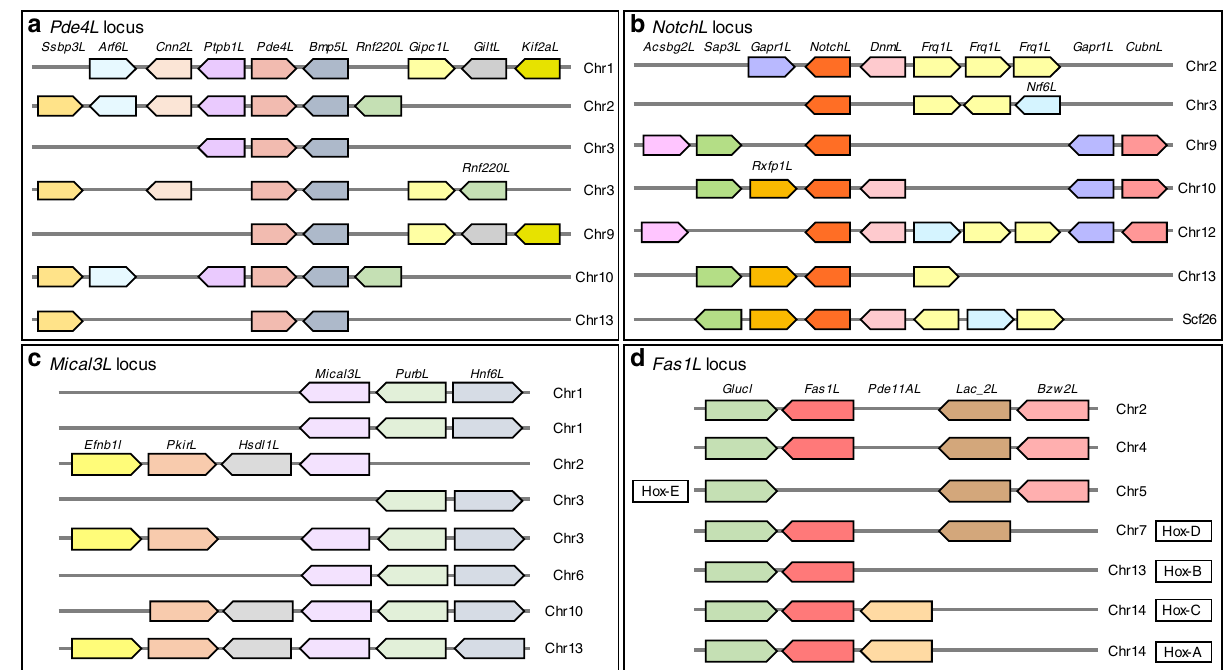
Fig. 5 Syntenic blocks with multiple paralogous loci in the mangrove HSC genome. a “ Pde4L locus ” , b “ NotchL locus ” , c “ Mical3L locus ” and d “ Fas1L locus ” . Chromosomal coordinates of these loci and their corresponding homologs in bark scorpion and tick are shown in Supplementary Figs. 4 – 7. Five of the Fas1L loci ( d ) are linked to the Hox clusters as shown. While the Hox-A, Hox-B, and Hox-C clusters are located within 350 kb from their corresponding Fas1L locus, the Hox-D and Hox-E clusters are located ~10 Mb and 4 Mb away, respectively (see chromosomal coordinates in Supplementary Figs. 3 (Hox clusters) and 6 (Fas1L locus).